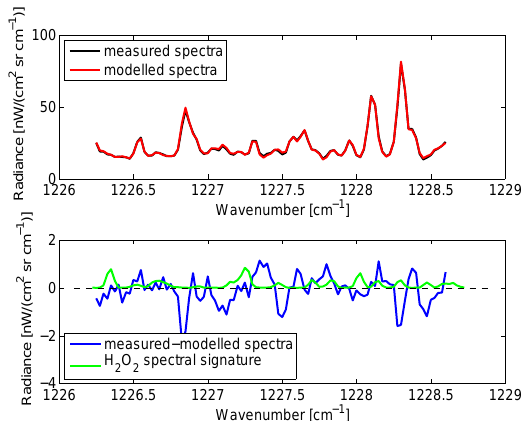
Fig. 2. Different spectra averaged between 20 ◦ N and 20 ◦ S in about 30 km; Shown is main microwindow 2; Top: measured spectra (black), modelled spectra (red); Bottom: difference between mea- sured and modelled spectra (blue), H 2 O 2 spectral signature (green) titude region due to absorption cross sections of N 2 O 5